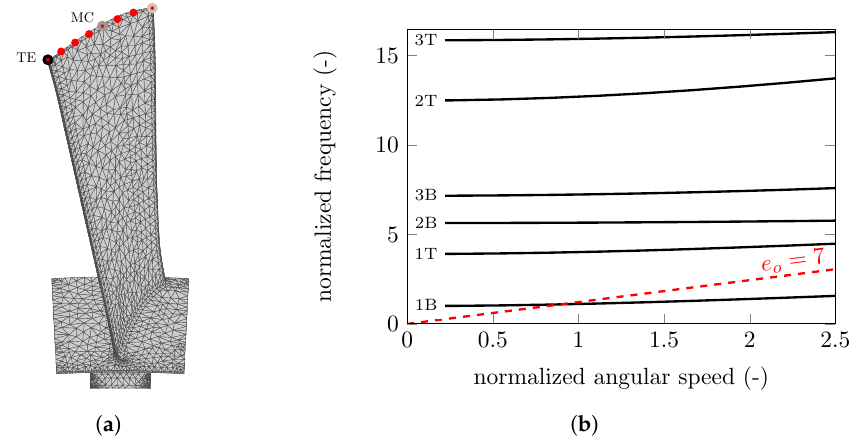
Figure 14. Finite element model ( a ) and Campbell diagram ( b ) of the LP compressor